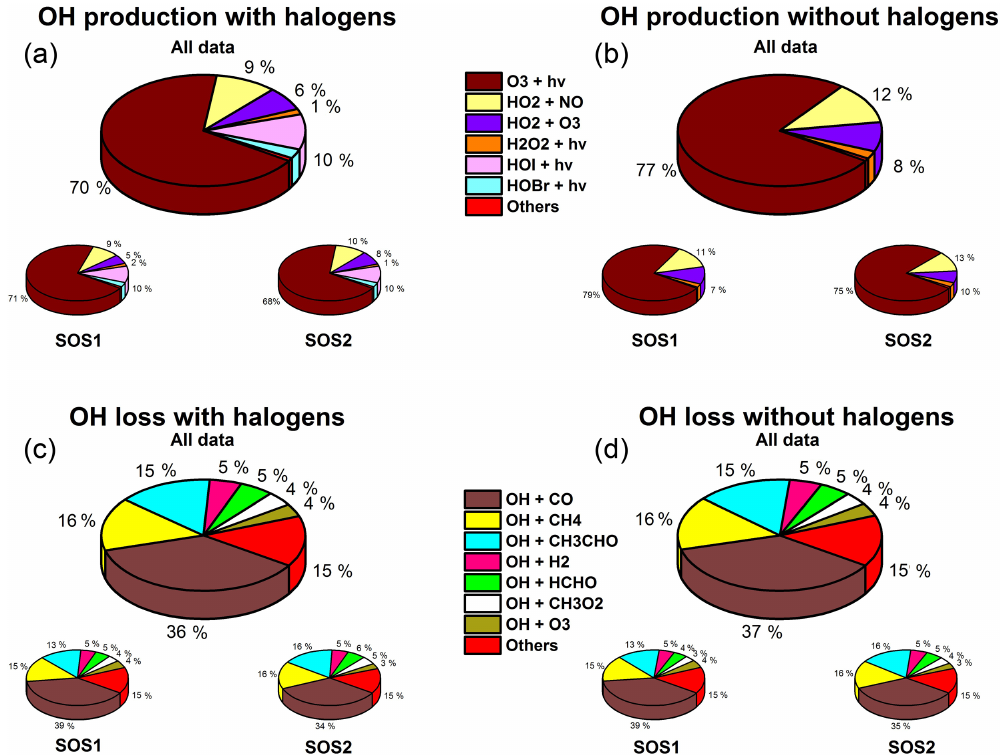
Figure 5. Processes controlling the (a) instantaneous OH radical production around noon (11:00–13:00LT) for box model simulations with halogen chemistry; (b) the instantaneous OH radical production around noon for box model simulations without halogen chemistry; (c) the instantaneous OH radical loss around noon for box model simulations with halogen chemistry; (d) the instantaneous OH radical loss around noon for box model simulations without halogen chemistry. The main charts show the average results for SOS1 + SOS2, with results for SOS1 and SOS2 shown separately in the smaller